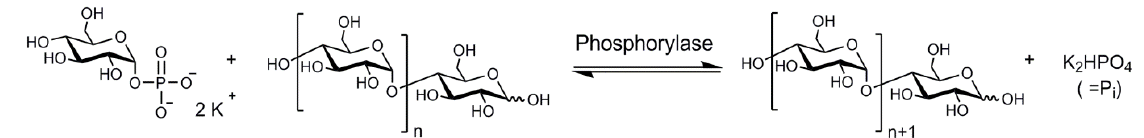
Figure 1. Action of potato